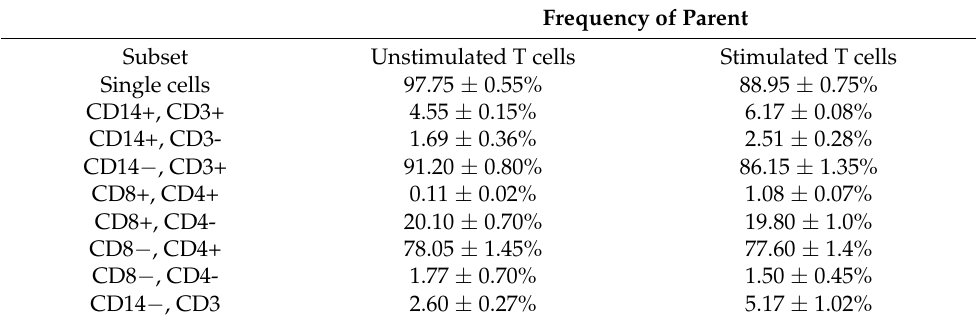
Table 1. Characterization of T cell populations with flow cytometry 1 .